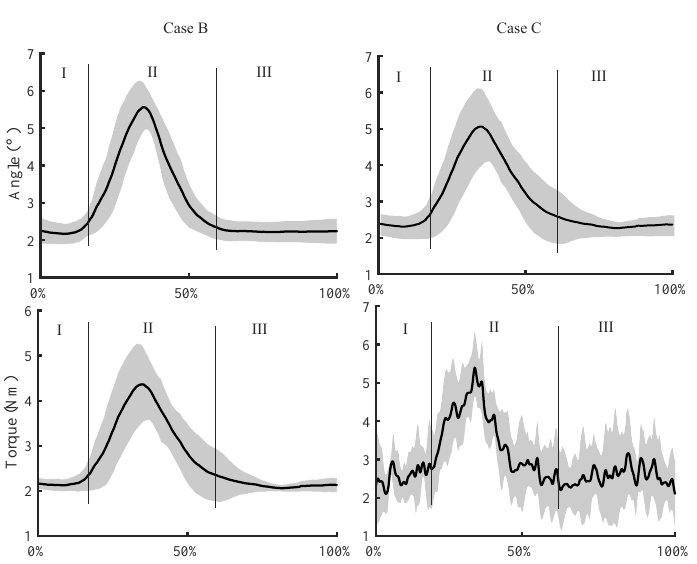
Figure 9. Ankle angle measurement results of participants and the output torque of the controller. For a better illustration, the root-mean-squared (RMS) of muscle activation was cal- culated to assess the assisted fitness. The muscle activation RMS values of participants in the three experiments are shown in Figure 10, with error bars representing standard deviation. The maximum standard deviation was 0.05, which has less effect on this experi- ment. According to Case A and Case B experimentation results, the RMS of Gas muscle and Sol muscle in Case B experimentation were reduced by an average of 20.33%, and 17.29%, respectively. The results indicated that the ankle exoskeleton can effectively as- sist the participant to resist disturbance upright under the virtual-ankle stiffness control method. By comparing Case B and Case C experimentation results, the RMS of Gas muscle and Sol muscle in Case C experimentation were reduced by an average of 3.12%, and 4.78%, respectively. The results showed that the proposed virtual neuromuscular control method improves the performance of the ankle exoskeleton in the process of assisting the participant to resist disturbance